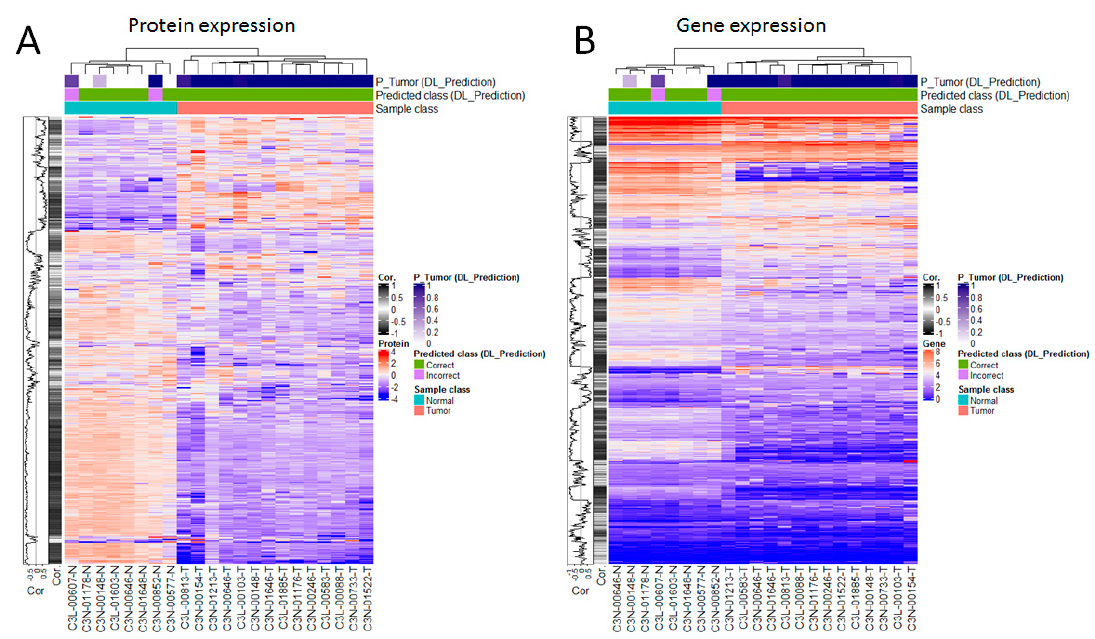
Figure 4. Analysis of the correlations between the proteomics data and their encoding genes, and between each dataset and the histology-based predictions. ( A ) Focus on the proteomics data. ( B ) Focus on the gene expression data. In each plot, the rows show proteins ( A ) and their corresponding coding genes ( B ) in alignment to facilitate comparative visualization, i.e., each row in each heatmap refers to a protein and its coding gene. Analysis performed on 22 samples with matched proteomics, gene expression and imaging data available.